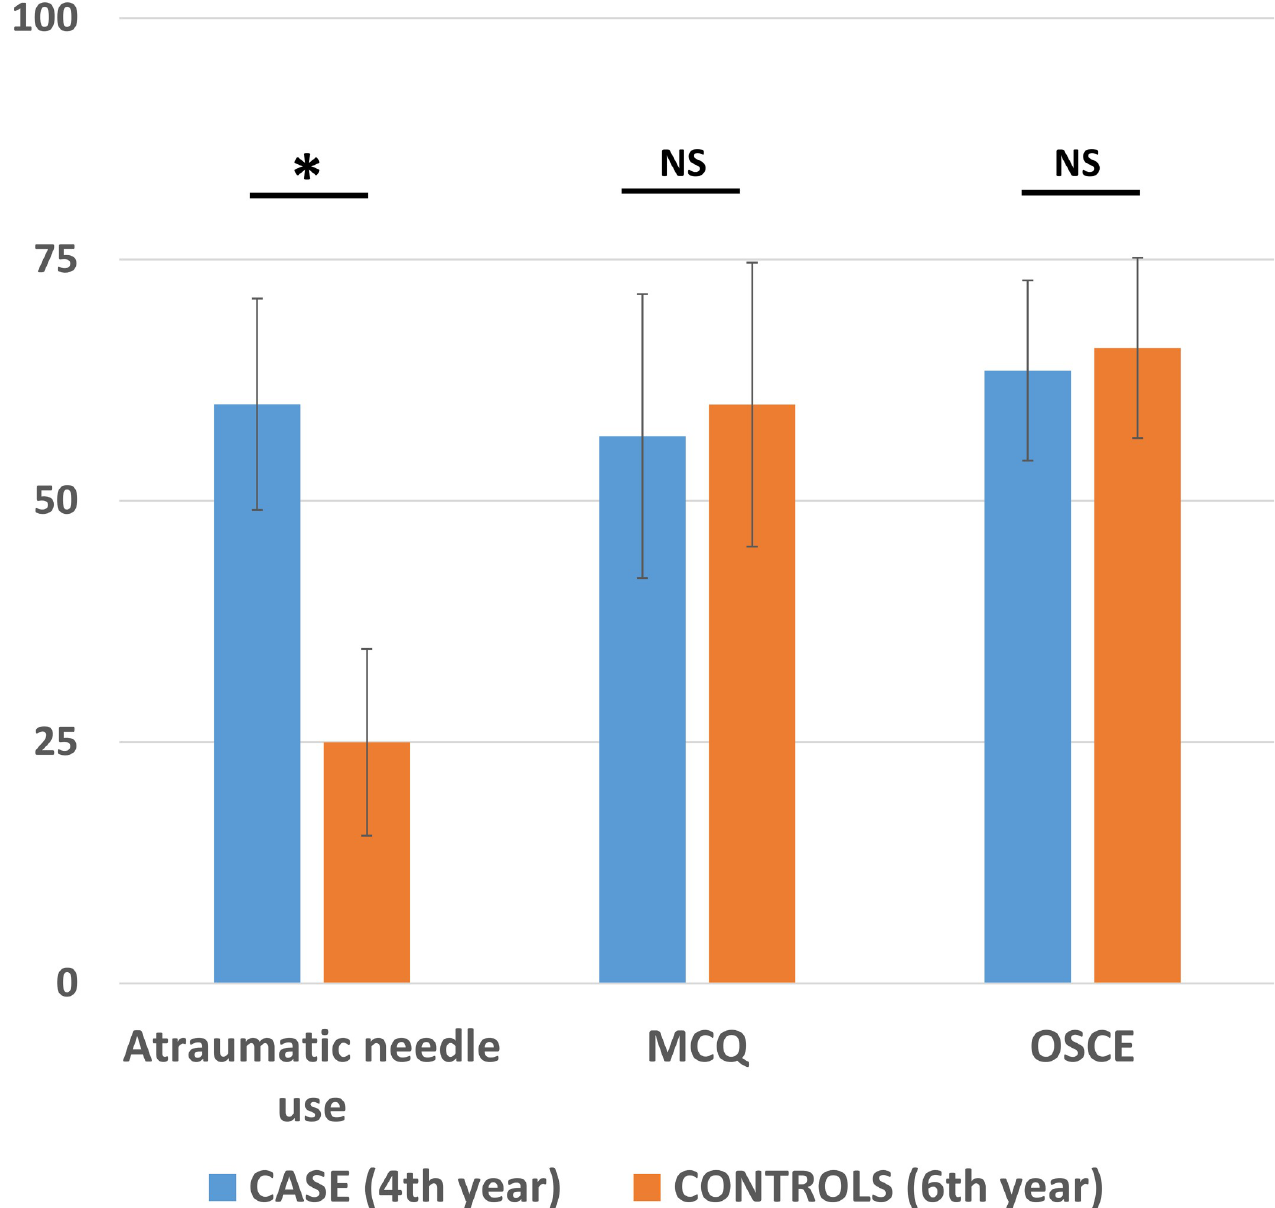
Fig 2. Proportion of students using an atraumatic needle during the evaluation, theoretical and practical scores. Percentage, multiple choice questionnaire (MCQ) and objective structured clinical examination (OSCE) scores for 4th year students with specific training and for 6th year students after classical clerkship are presented. Scores are expressed out of 100 and the standard deviation is shown. Atraumatic needle use differed significantly between the two groups of students ( p = 0.025). NS: no significant difference.